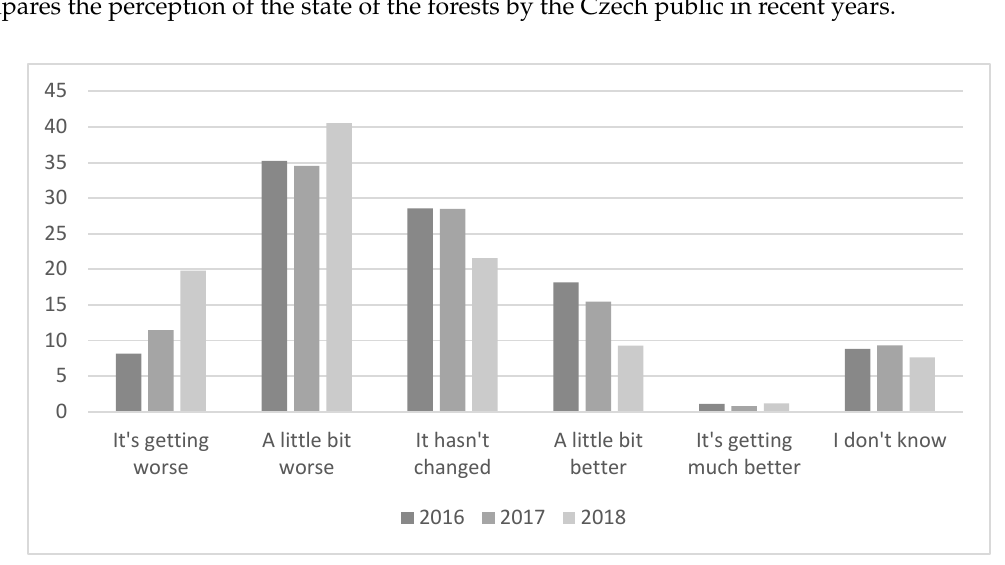
Table 2. Which of the following sources of information do you consider to be the most important for yourself in terms of information on forests and forestry? (data in %, source A2018).